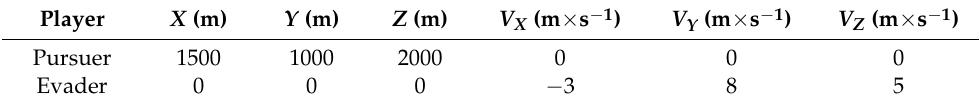
Table 2. Positions and velocities of the initial time.